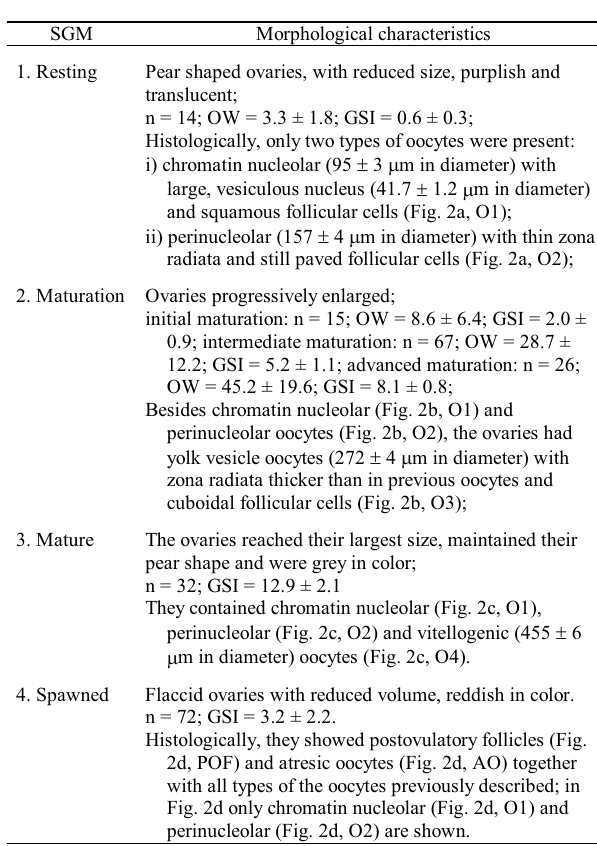
Table 1 . Stages of gonadal maturation of the female yellow- mandi ( Pimelodus maculatus ) in Igarapava Reservoir (SGM = stage of gonadal maturation; n = number of fish analyzed; OW= ovarian weight, g; GSI = gonadosomatic index).